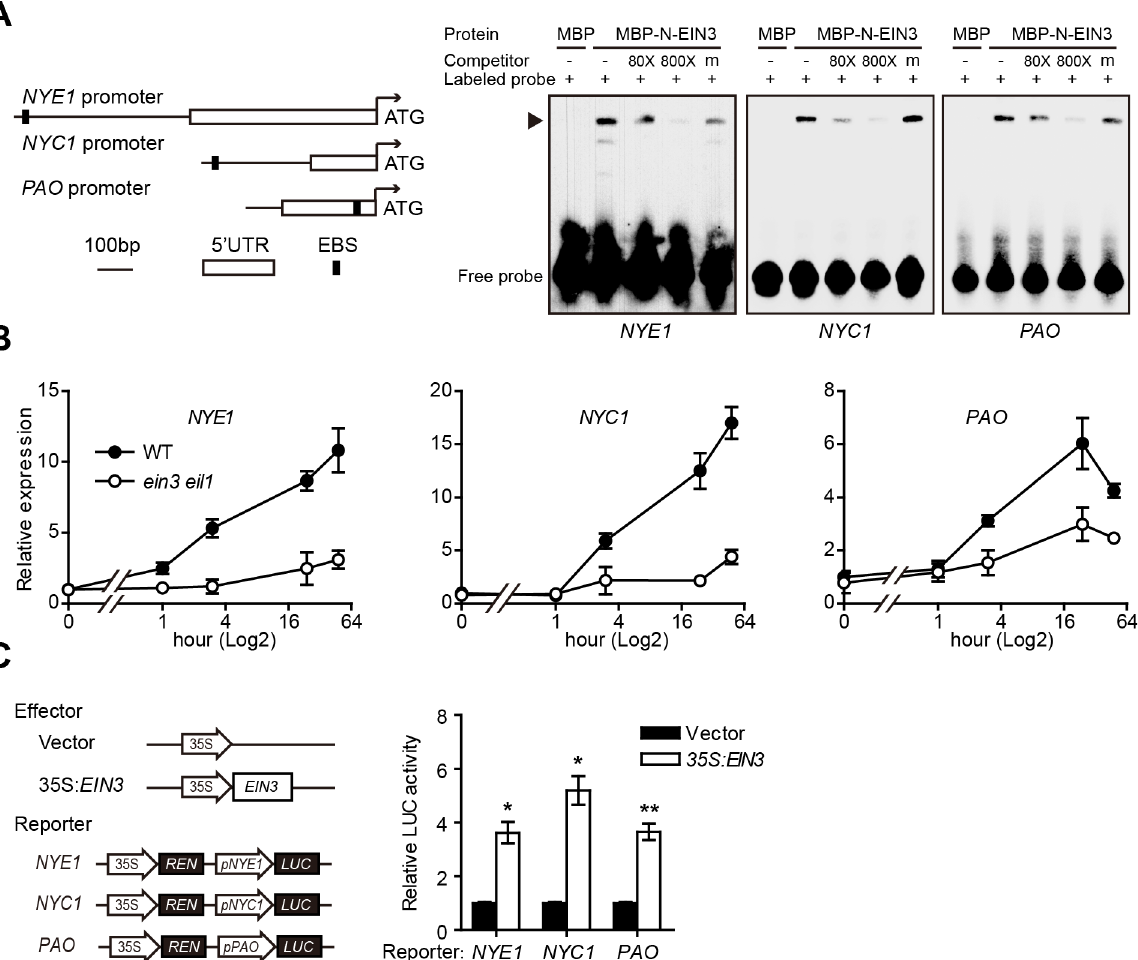
Fig 2. EIN3 directly associates with and transactivates the promoters of NYE1 , NYC1 , and PAO . (A) Left panel: Schematic diagrams of EIN3 binding site (EBS) in the promoter or 5 ’ -UTR regions of NYE1 , NYC1 , and PAO . Right panel: EIN3 physically interacts with the promoters of NYE1 , NYC1 , and PAO in EMSA. About 30-bp DNA fragments containing the EBS in the promoters or 5 ’ -UTR of NYE1 , NYC1 , and PAO were used as probes for EMSA. Mutated version of competitor DNA (m) was added in 800-fold molar excess. “ ‒ ” and “ + ” represent absence or presence, respectively. Triangle indicates the DNA- protein complex. (B) Kinetic analysis of NYE1 , NYC1 , and PAO expression in leaves of WT and ein3 eil1 in response to ethylene. Experiments were performed as in Fig 1A. The expression of each corresponding gene in the WT at 0 hr was set to 1. Data are mean ± SEM of 3 biological replicates with technical duplicates for each. (C) Left panel: Schematic diagrams of effector and reporter constructs used in the transient dual-luciferase assays. CaMV 35S promoter driving EIN3 ( 35S : EIN3 ) was used as effector, and the empty vector was used as a control. The dual-luciferase reporter constructs consist of 35S driving Renilla luciferase (REN) reporter gene for internal normalization, and the promoters of NYE1 (2012 bp), NYC1 (493 bp), PAO (365 bp) driving firefly luciferase (LUC) reporter gene. Right panel: transient dual-luciferase assay of EIN3 transactivating the promoters of NYE1 , NYC1 , and PAO in Arabidopsis protoplasts. The procedure was as in Fig 1B. Data are mean ± SEM of at least 3 biological replicates. * p < 0.05, ** p < 0.01 ( t